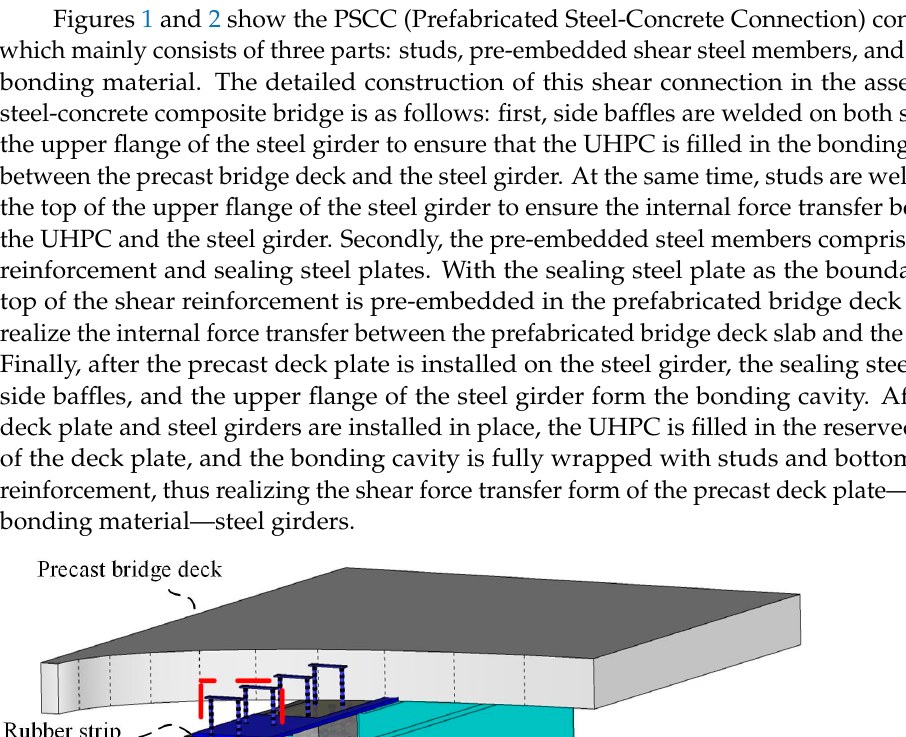
Figure 2. Design of PSCC connectors. 2.2. Structural Features Depending on the assembly process in a real bridge, the PSCC connector is divided into two parts: the deck plate section with the shear connection steel member and the steel girder section with side baffles and studs. The load is transferred from the prefabricated deck slab to the bonding cavity section and then to the steel girders via shear reinforce- ment and studs. PSCC connectors offer an efficient assembly process and superior perfor- mance, the main advantages of which can be classified as follows: (1) PSCC shear connectors do not change the structure of prefabricated bridge decks and do not require slotting to cause weak areas in the deck, ensuring the overall perfor- mance of the deck. (2) During the bridge deck slab’s installation, the sealing steel plate was in the middle of the shear connection steel member. This permitted to convert the traditional connec- tion between precast concrete and steel girders into a kind of connection between steel structures during alignment. The whole bridge deck slab and the shear connec- tion steel member were made in the factory, thus significantly improving the match- ing accuracy during installation. (3) Based on the superb mechanical properties of UHPC, the reliability of the connection between the studs and the pre-embedded steel members can be ensured, and the shear force transfer path is clarified to ensure the designability of this shear connec- tion.